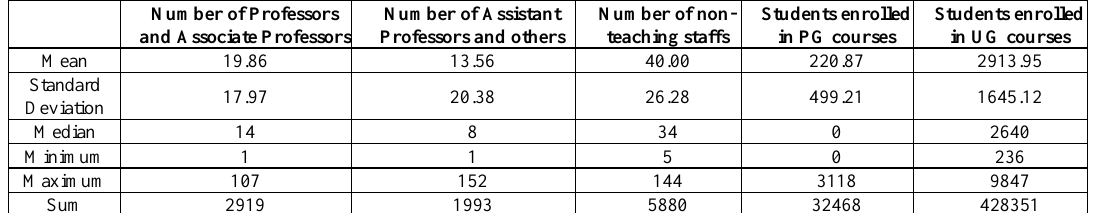
Table 2. Summary statistics of input and output data of 147